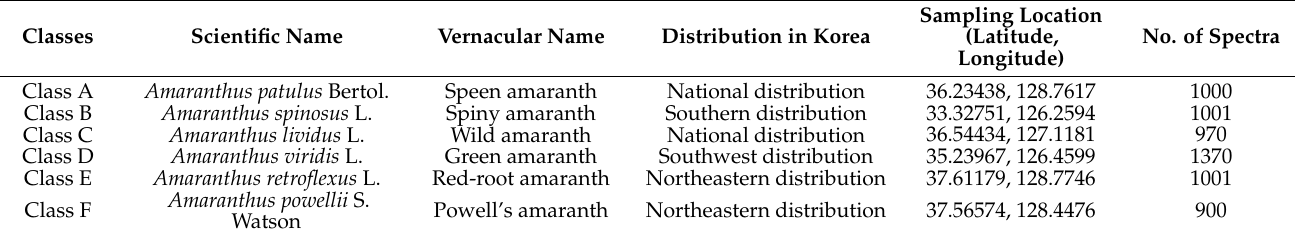
Table 1. List of Amaranthus sp. studied in this